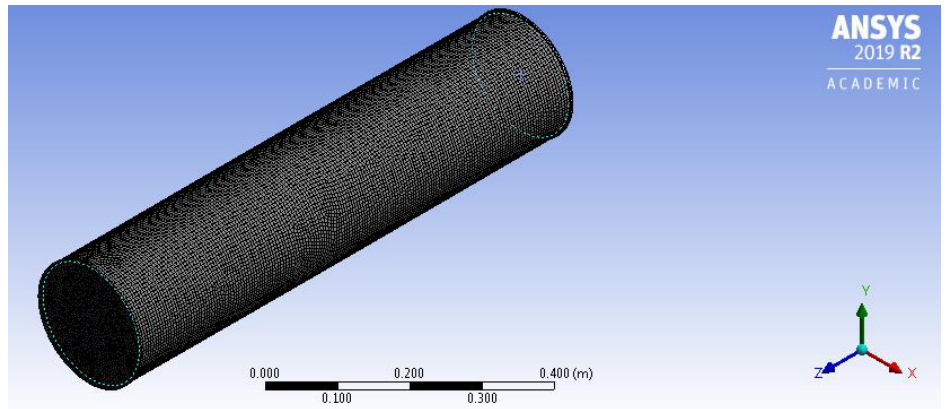
Figure 15. Most refined mesh used for the shell with sliding stiffeners.